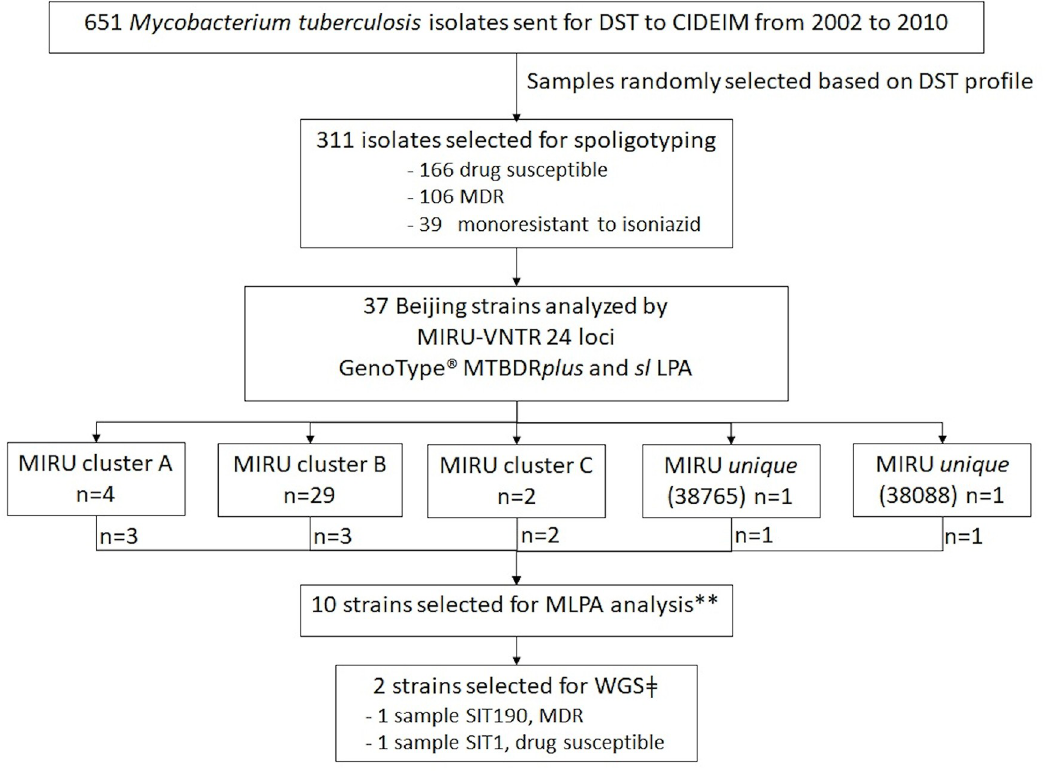
Fig 1. Workflow for the selection of Mycobacterium tuberculosis strains to identify and characterize Beijing strains from Southwestern Colombia. DST: Drug susceptibility testing; MDR: Multidrug Resistant; MIRU-VNTR: Mycobacteria Interspersed Repetitive Unit–Variable Number Tandem Repeat; MLPA: Multiplex Ligation-dependent Probe Amplification; LPA: Line probe assays; WGS: Whole Genome Sequencing.